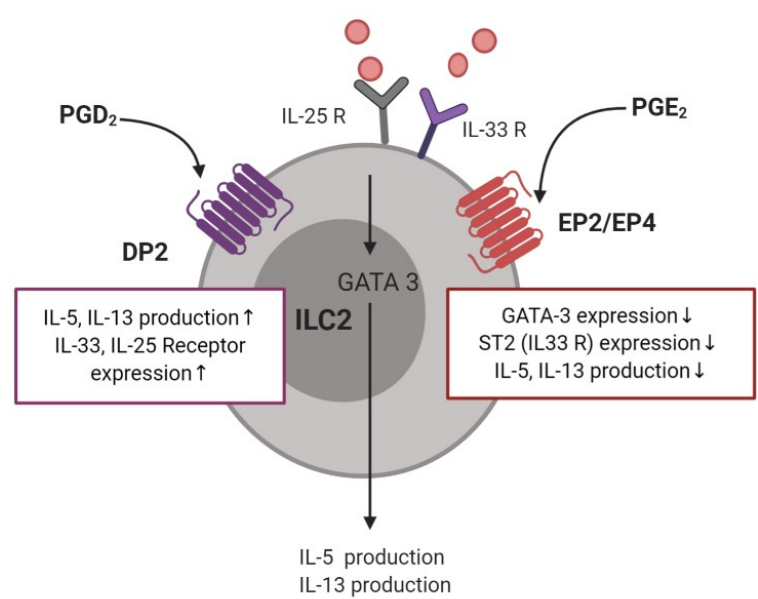
Figure 4. The role of prostaglandins and their receptors in type 2 innate lymphoid cells.